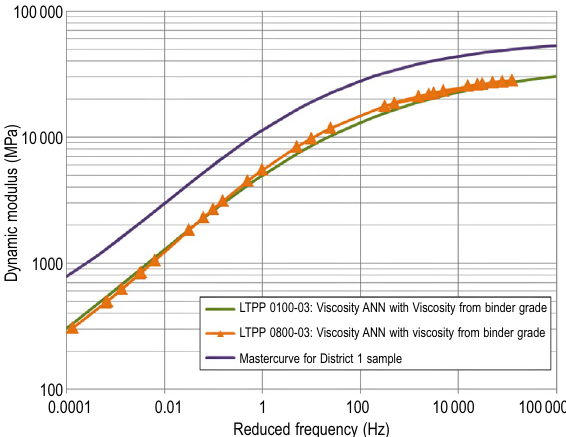
Fig. 4. Dynamic modulus mastercurves from laboratory tests and LTPP viscosity based ANN model with viscosity from binder grade for New Mexico District 1